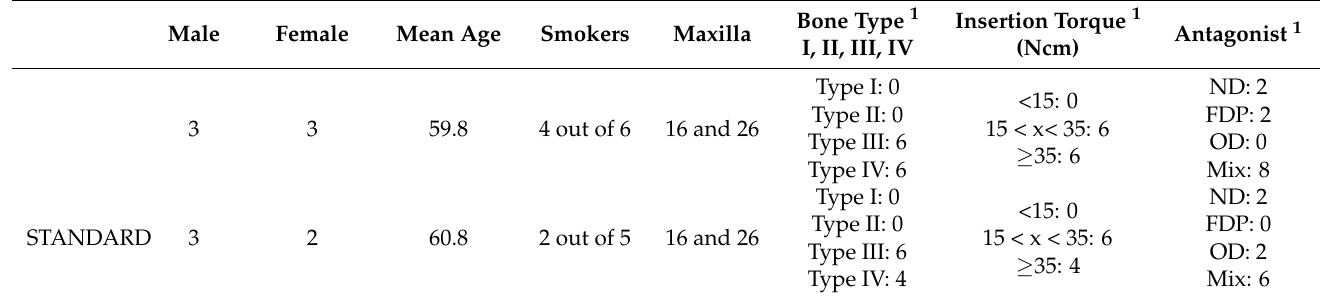
Table 1. Demographic and clinical data.